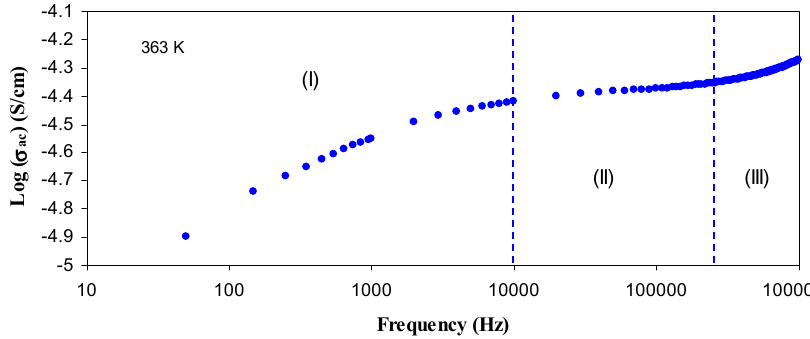
Figure 8. AC conductivity spectra for SPE5 sample at selected temperatures. Clearly the plateau region (Region II) shifts to higher frequency side with increasing temperature.